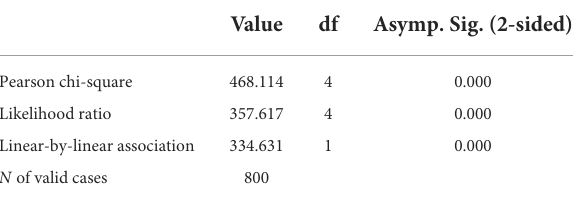
TABLE 4 Chi-square test between the dimension of assurance and satisfaction for the quality of services in public hospitals.